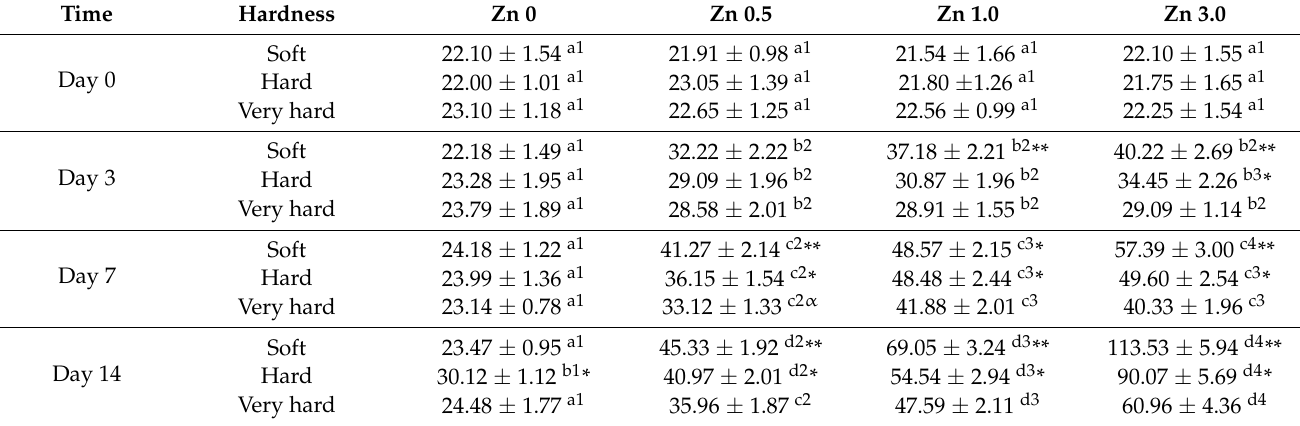
Table 3. Zinc accumulation in the fish body (ppm).